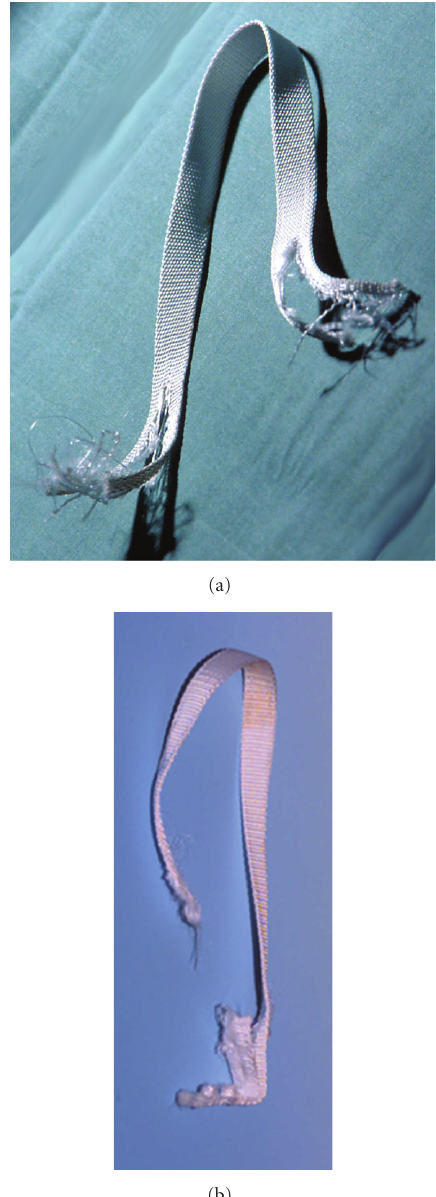
Figure 4: Ruptured Trevira cord after quasistatic loading (a) and (b) after cyclic